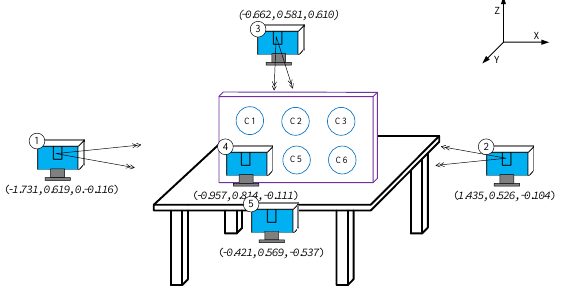
Figure 4. Experiment setup of the scanning angle effect study In this experiment, the LiDAR data is analysed using Liu’s (2010) quantification algorithm. Figure 5 is the quantification result of the area and volume cylindrical samples scanned from the 5 different positions.